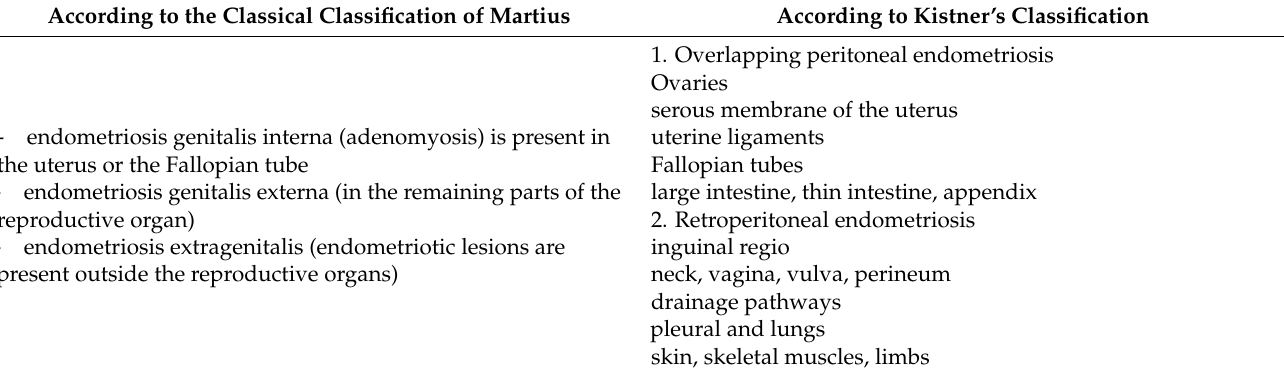
Table 3. Types of divisions of endometriosis by location. According to Kistner’s